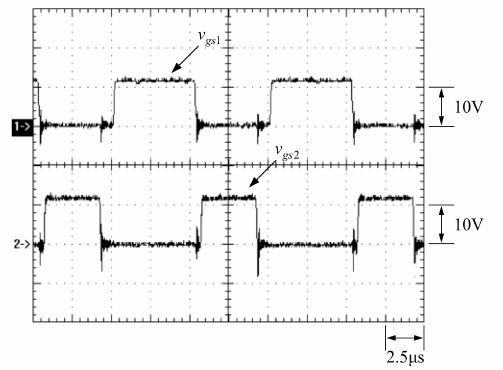
Figure 15. Experimental waveforms: (1) v gs 1 ; (2) v gs 2